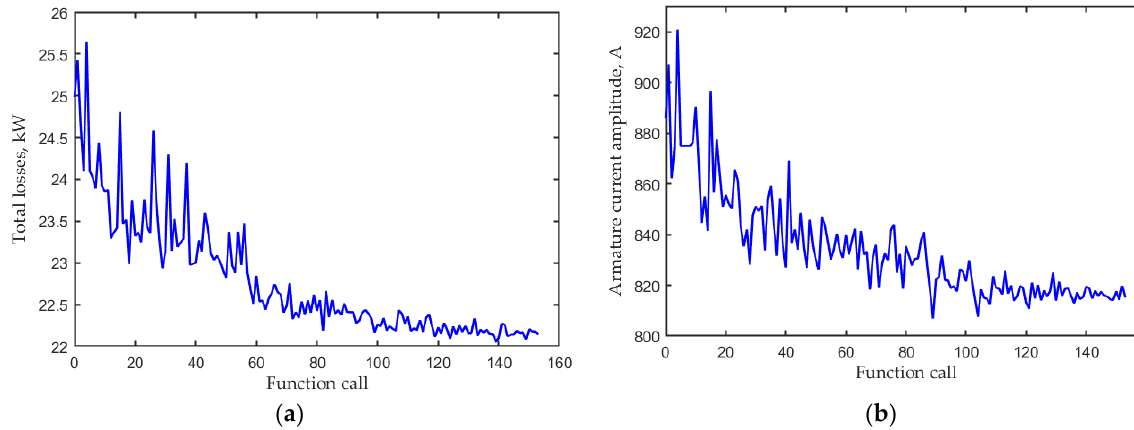
Figure 6. ( a ) Variation in the total losses <P losses > during the optimization; ( b ) variation in the maximum current amplitude in the armature winding during the optimization.